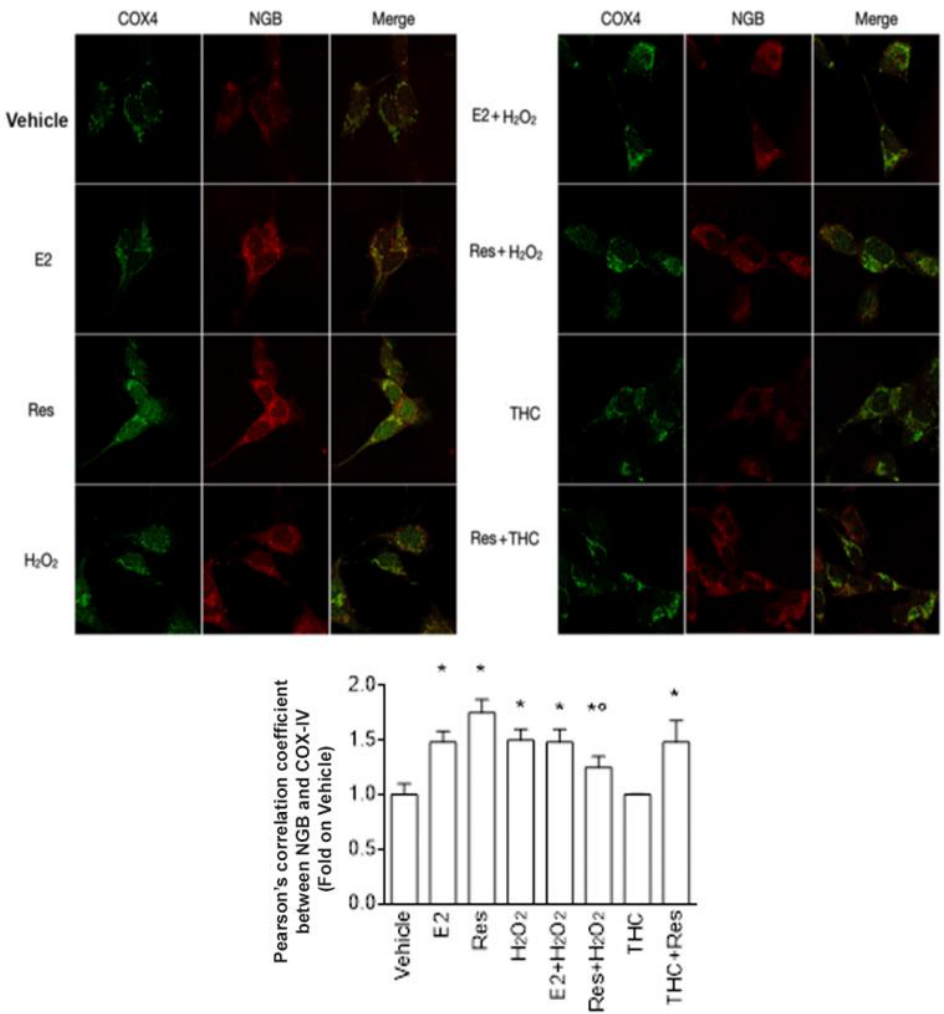
Figure 5. Effect of Res on NGB mitochondrial localization. (Upper panels) Confocal microscopy analysis of NGB/COX4 colocalization in SH-SY5Y cells treated with vehicle (DMSO 1:1000), E2 (10 − 9 M), Res (10 − 7 M), H 2 O 2 (5 × 10 − 5 µ M), and E2 + H 2 O 2 , Res + H 2 O 2 and (R,R)-THC + Res treatments at the same concentrations; (R,R)-THC (10 − 6 M) was administrated 1 h before the other treatments (24 h). NGB was labeled in red, while COX4 was in green. (Bottom panel) shows the Pearson’s correlation coefficient, calculated with respect to the vehicle-treated samples, of at least six different experiments. Data are reported as mean ± SD. p < 0.01 was calculated with Student’s t -test with respect to vehicle (*) or Res ( ◦